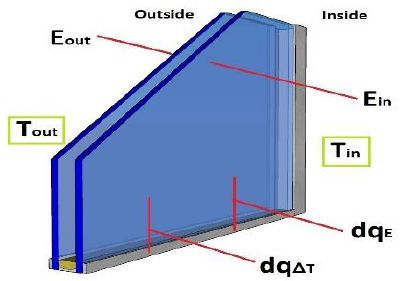
Figure 5. Schematic representation of energy flows and relevant nomenclature: E_{out} (W·m −2 ) is the global (on vertical plane) impinging solar irradiance measured by a thermopile pyranometer; E_{in} (W·m − 2 ) is the global (on vertical plane) transmitted solar irradiance into the room measured by a thermopile pyranometer; dq_{\mathrm{\Delta T}} (W·m −2 ) is the heat flux towards the interior due to the thermal gradient between outside and inside; dq_E (W·m −2 ) is the heat flux due to absorbed solar radiation. Adopted from Goia et al. [24].